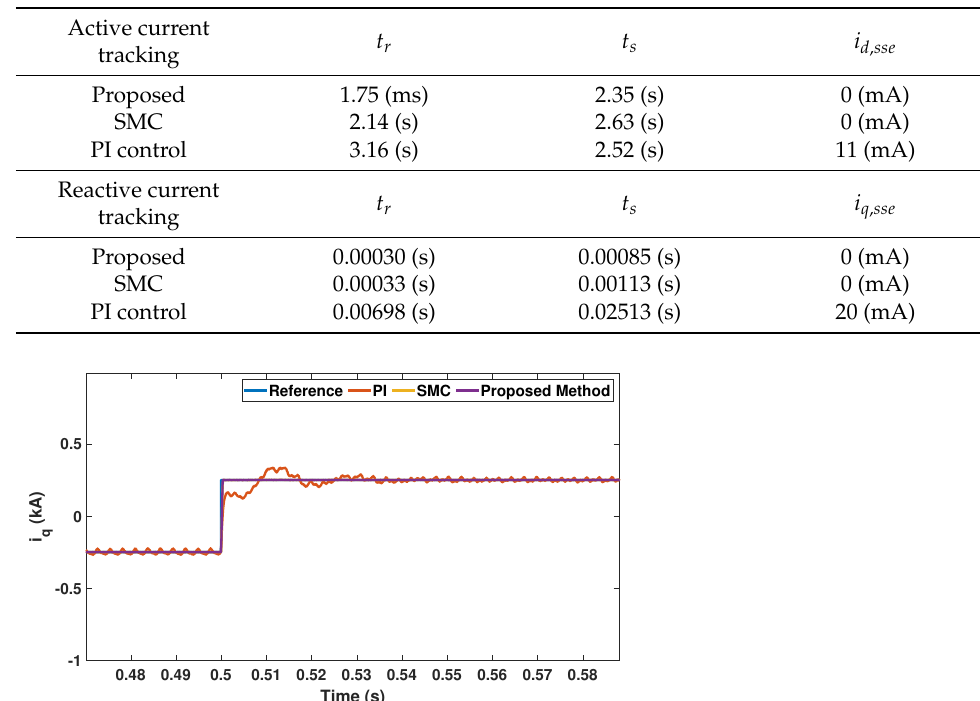
Table 3. Comparative table of Case 1.